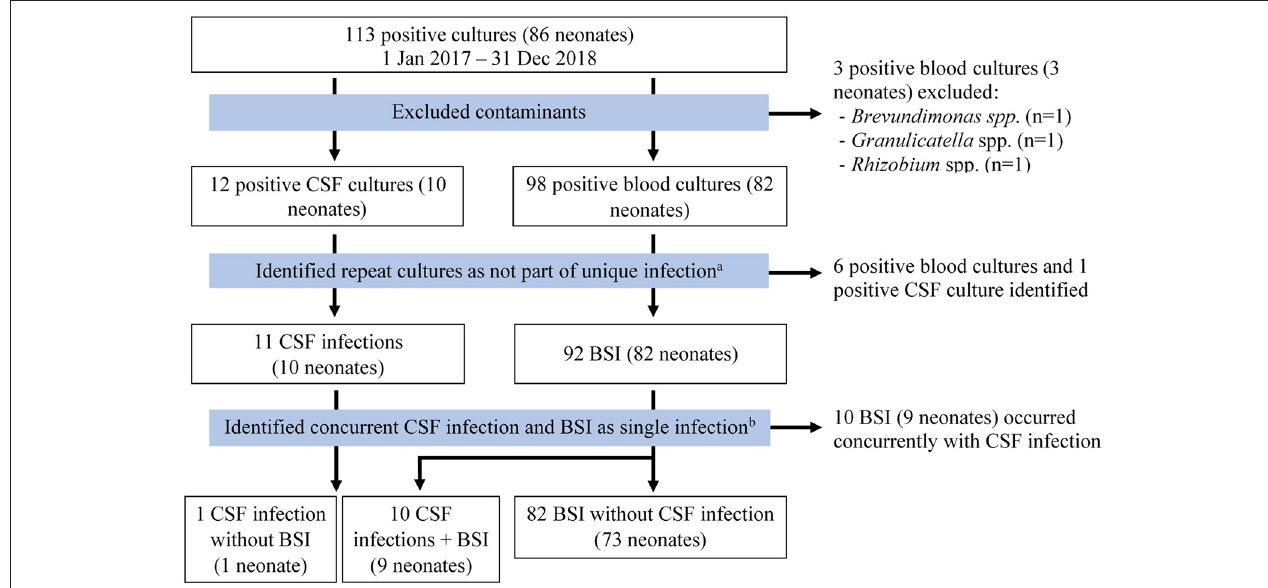
FIGURE 1 | Flow diagram used to identify unique infections. Meningitis and CSF infection were used interchangeably. a Multiple positive cultures from the same neonate were considered part of the same culture-positive infection unless a distinct organism was isolated, or the culture was drawn more than 7 days after the most recent positive culture. b Positive cultures with the same organism from both blood and CSF were considered as part of the same culture-positive infection. BSI, bloodstream infection; CSF, cerebrospinal fluid.